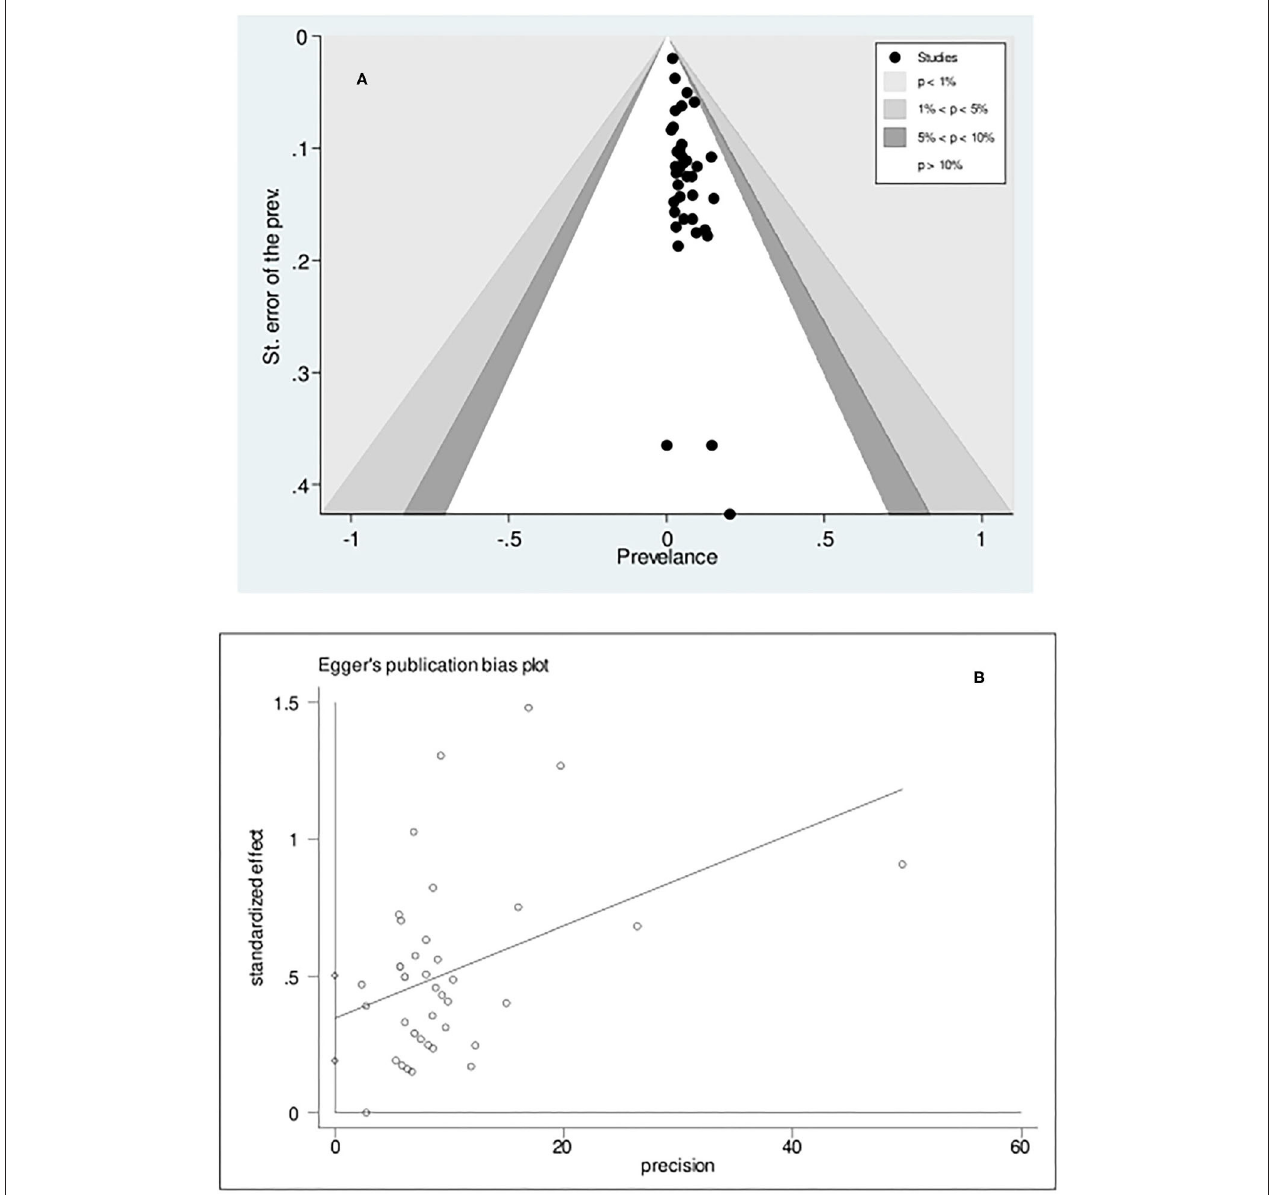
FIGURE 3 | Contour-enhanced Funnel plot (A) and Egger’s publication bias plot (B) examining small-study effects on the pooled celiac disease prevalence among patients with Turner syndrome. The estimated bias coefficient is 0.346 with a standard error of 0.077, indicating a p- value of <